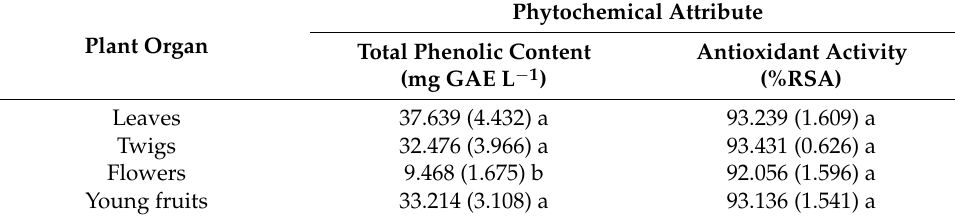
Table 2. Total phenolic content (TPC—mg GAE L − 1 extract) and antioxidant activity (AA) expressed as Radical Scavenging Activity (% RSA) were measured in four different plant organs of A. ovalis subsp. ovalis native Greek genotype GR-1-BBGK-04,2547.